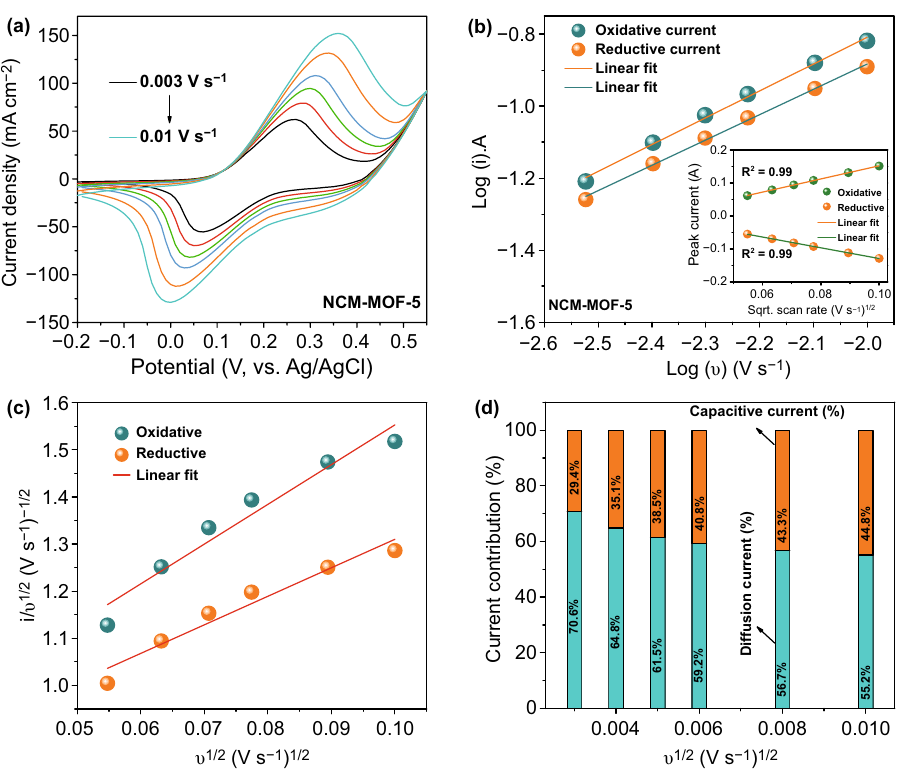
Fig. 4 Systematic investigation on the energy storage performance of the dual-layered NCM-based MOF-5 electrode. a CV curves of the NCM- based MOF-5 electrode measured at different scan rates and b logarithm relationship of oxidation and reduction peak current versus scan rate. c Plots of v 1/2 versus i/v 1/2 used for calculating the constants of k 1 and k 2 with oxidative and reductive currents of CV curves. d Capacitive- (orange color) and diffusion-controlled (cyan color) current contribution of the NCM-based MOF-5 electrode analyzed at various scan rates. The inset in b shows the linear relationship of the redox peak current versus square root of scan